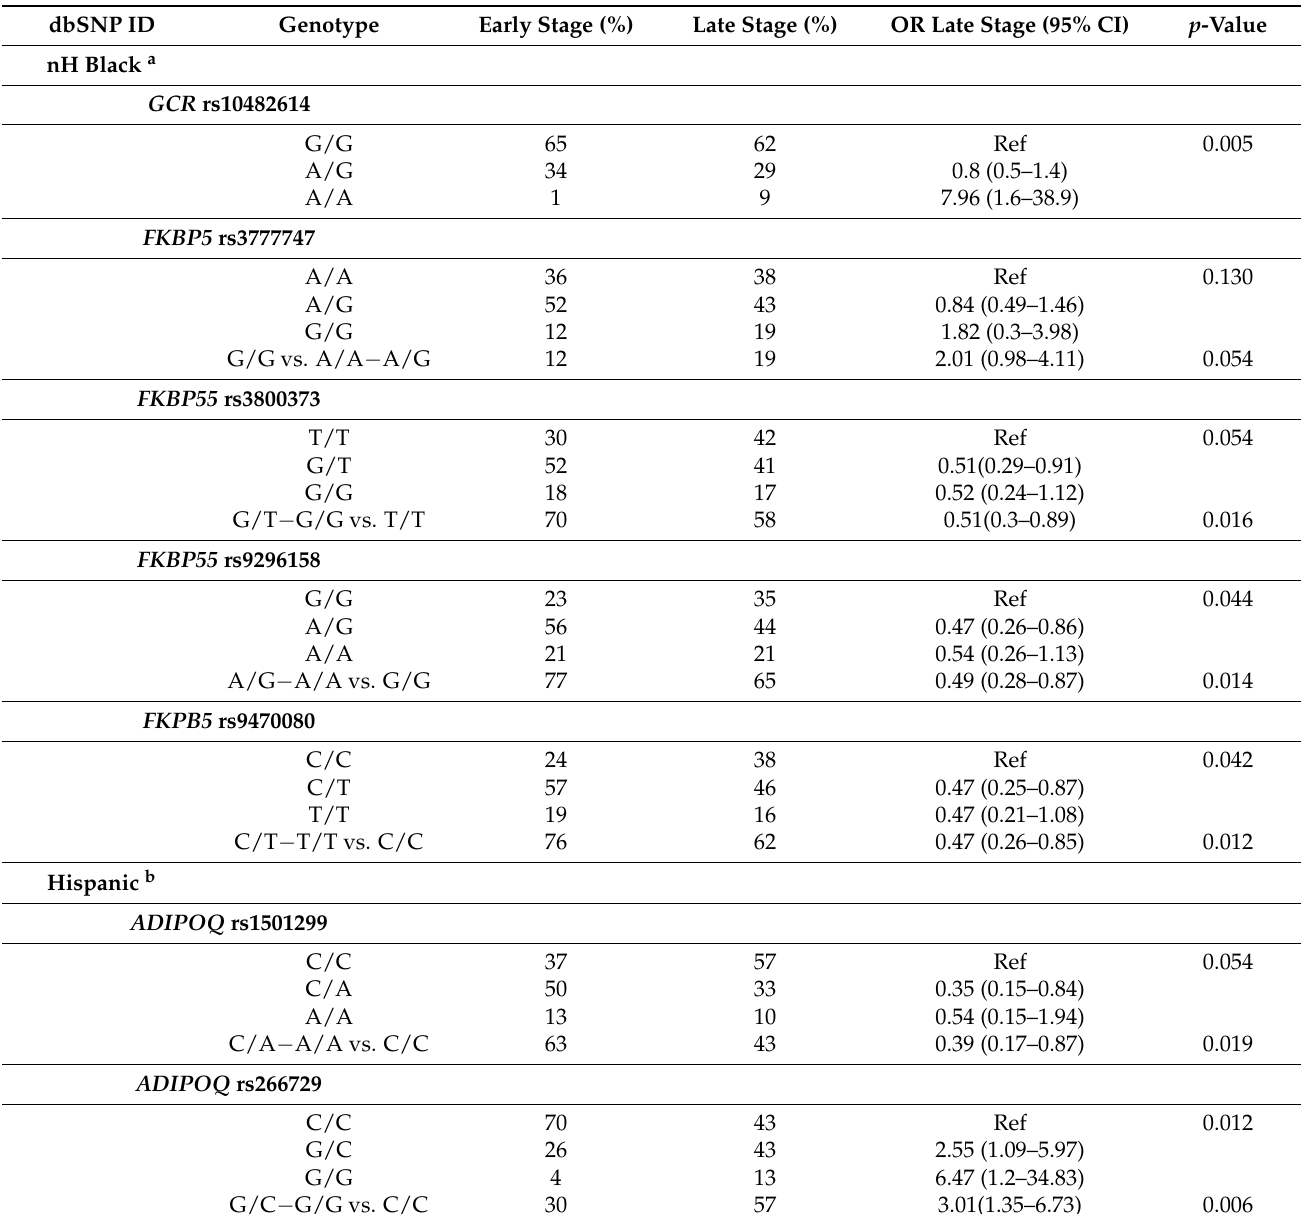
Table 3. List of SNPs with significant association with later stage at diagnosis ( p <